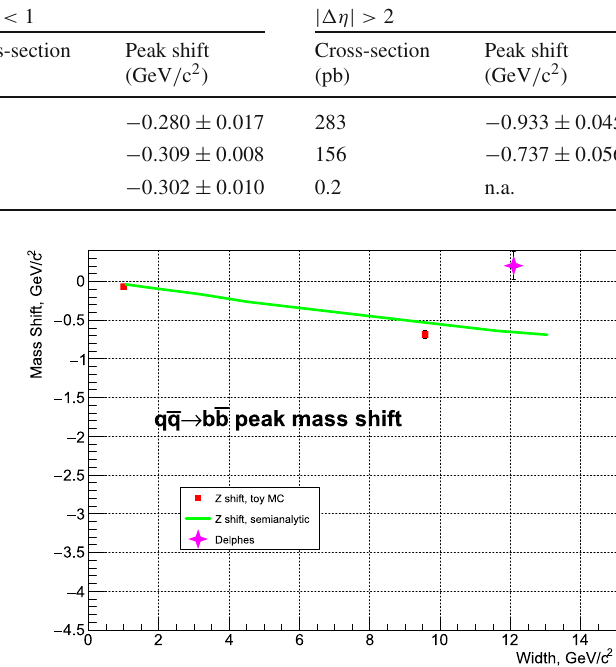
Fig. 4 The shift in the peak positions of Gaussian distributions fitted to u u (left)and bb (right) peaks, plotted against the fitted width. The squares show the impact of different smearing resolutions, and the star